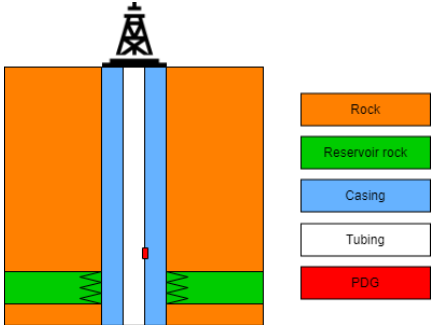
Figure 1. A common location of Permanent downhole gauge(PDG) in the